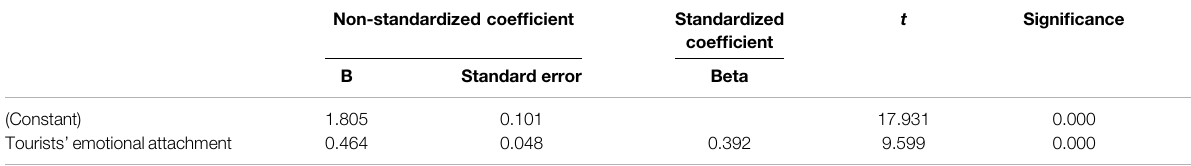
TABLE 4 | Analysis of the impact of emotional dependence perception on tourists ’ behavioral intentions.